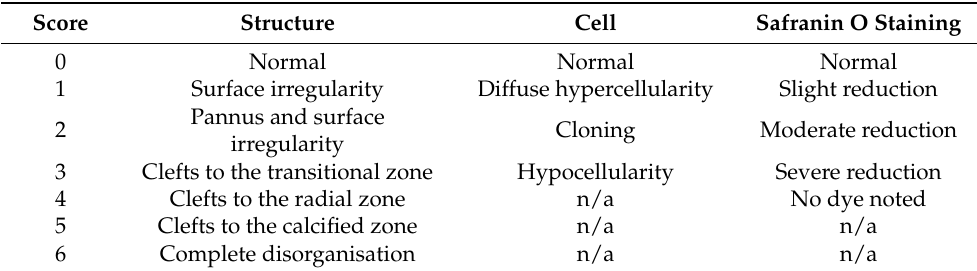
Table 1. Modified Mankin’s Scoring